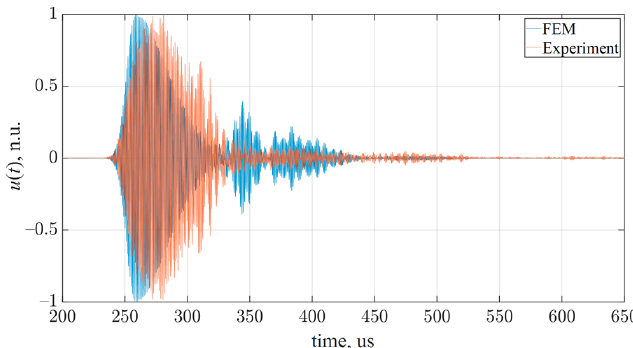
Figure 17. Comparison of simulated and experimental S 3 mode